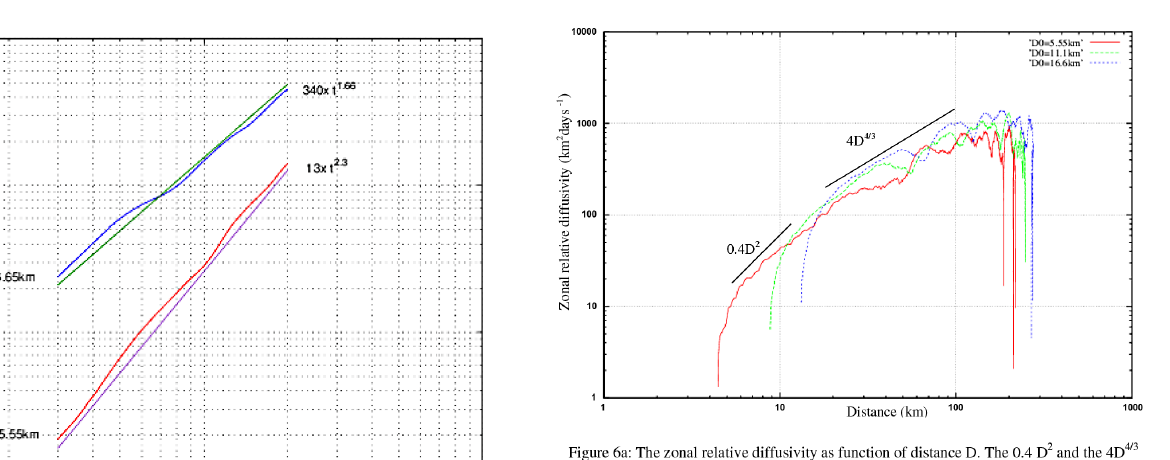
Fig. 6a. The zonal relative diffusivity as a function of distance D . 0.4 D 2 and 4 D 4 / 3 are plotted.